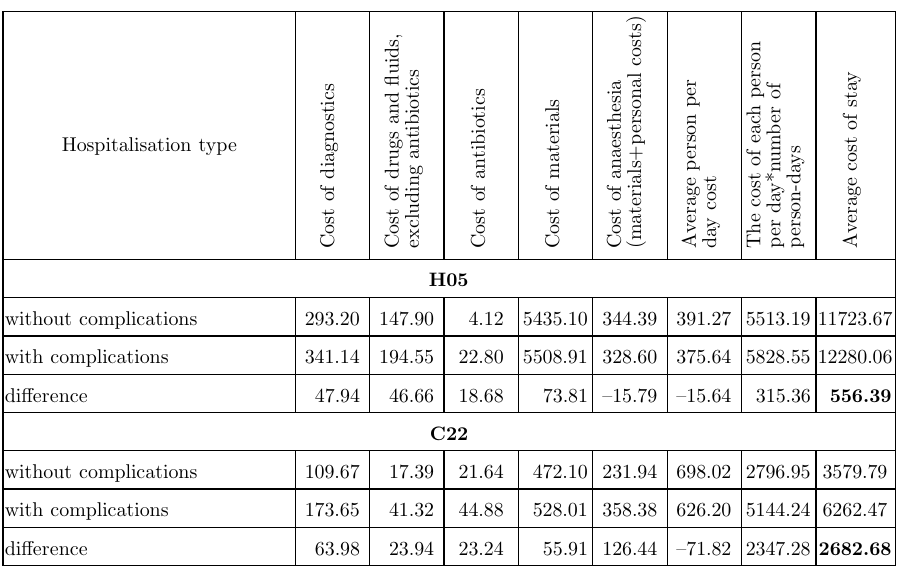
Hospitalisation type